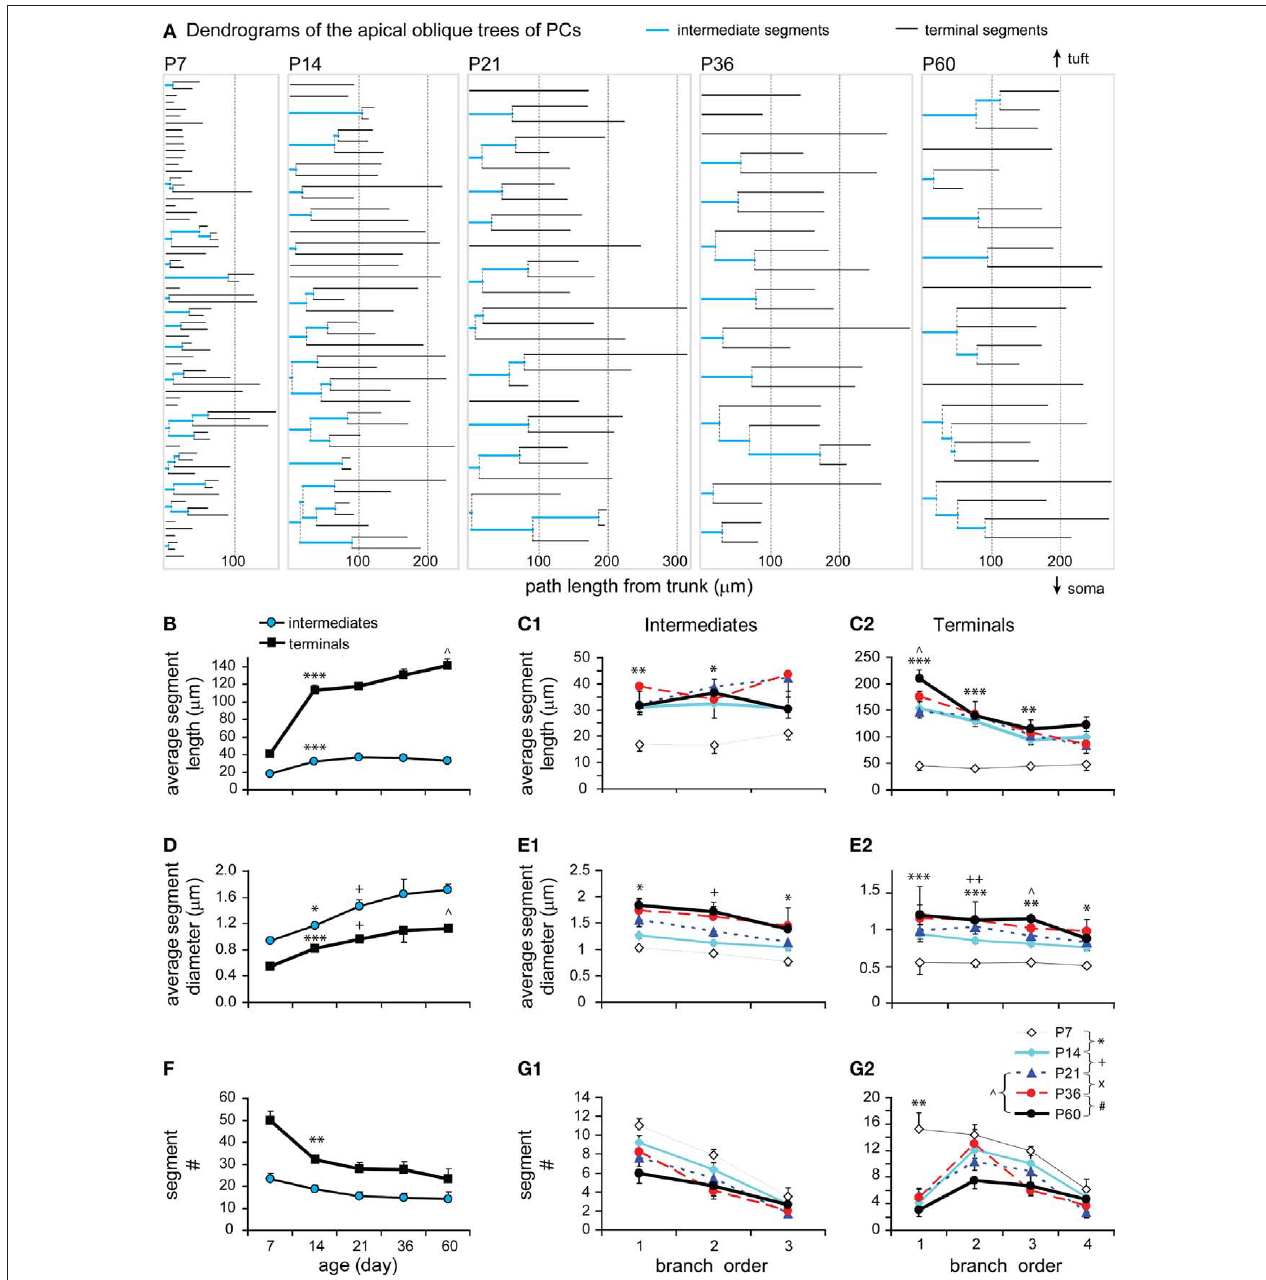
the average segment diameter kept increasing during the whole period studied. The significant increases were seen between P7 to P14 and P14 to P21 in both intermediates and terminals, and between P21 to P60 only in terminals. (e1) The intermediate segment diameter significantly increased on the first and third orders from P7 to P14 and on the second orders from P14 to P21. (e2) The terminal segment diameter significantly increased on all the orders first to fourth from P7 to P14, only on the second orders from P14 to P21, and only on the third orders from P21 to P60. (F) Average numbers of intermediate and terminal segments versus age [same cells as in (B) ]. There was not significant change in the segment number except a decrease in terminal segments from P7 to P14. (g1) The intermediate segment number was not significantly changed during the whole period studied. (g2) The terminal segment number was not significantly changed except a decrease on the first orders from P7 to